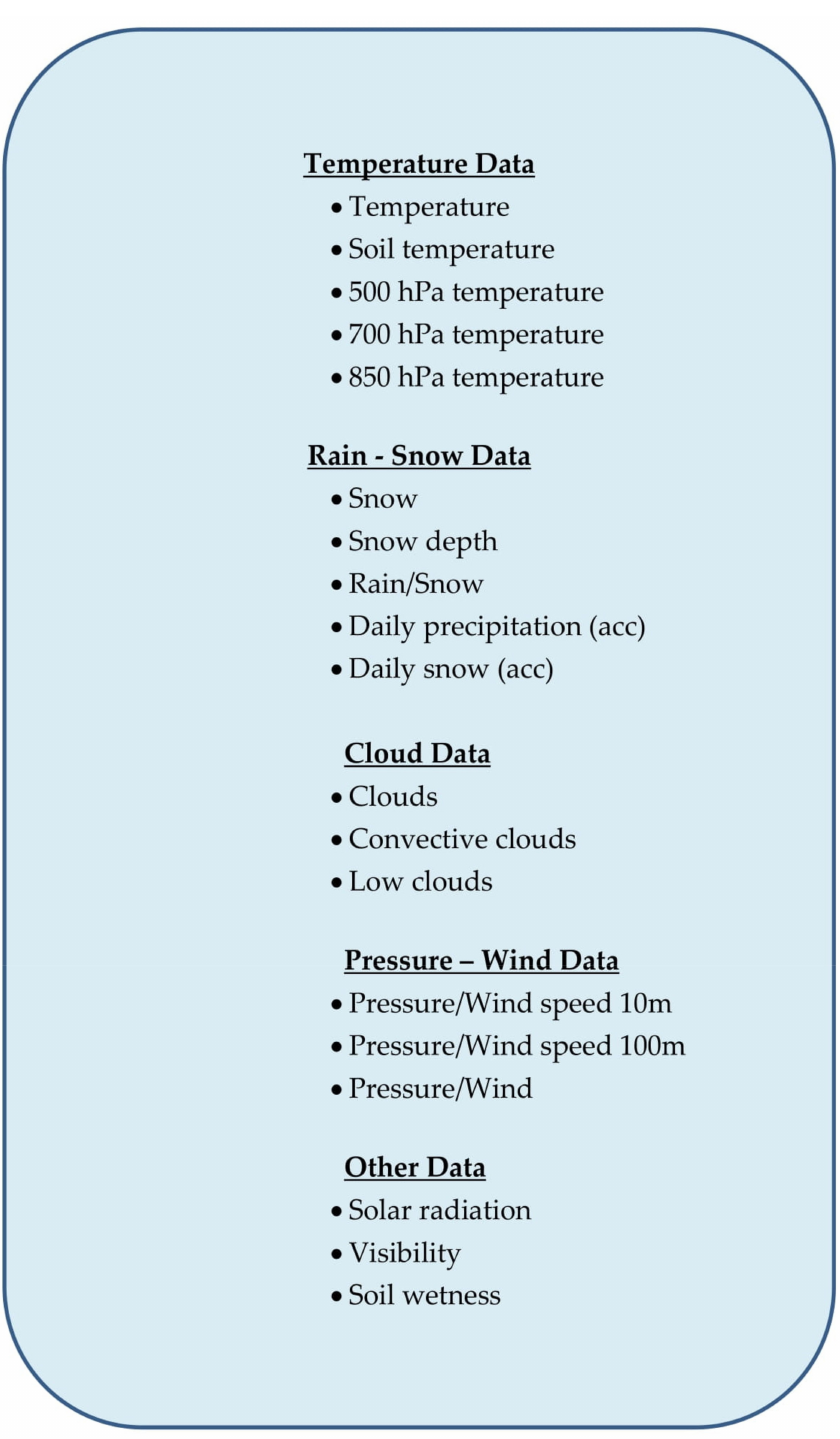
Figure 8. Data needed from Copernicus Climate Change Service